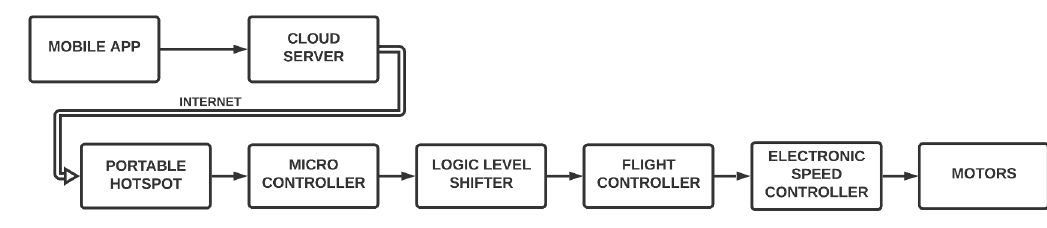
Figure 1. Block Diagram of Drone